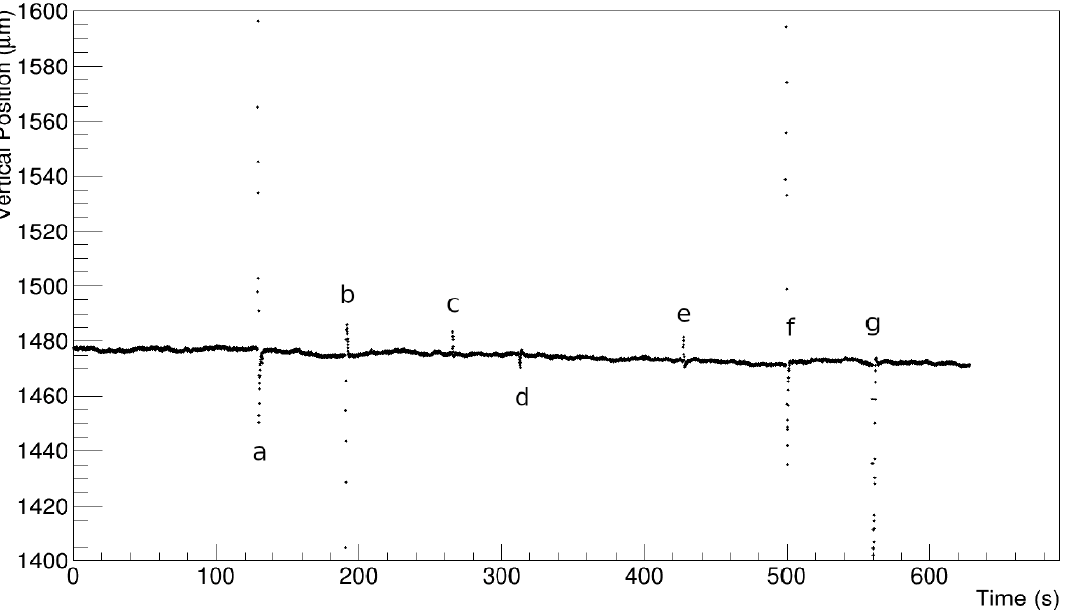
Figure 11. Vertical position observed by NanoMAX. The points where large perturbations are observed (points “a”,“b”,“f”, and “g”), correspond to direct bump changes performed in the same plane for the BioMAX beamline. See main text for